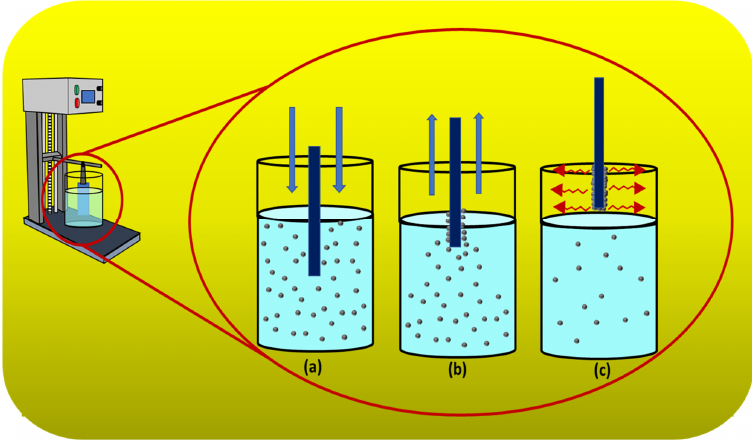
Figure 1. Schematic diagram of dip-coating process. ( a ) Dipping. ( b ) Withdrawing and deposition. ( c ) Solvent evaporation and